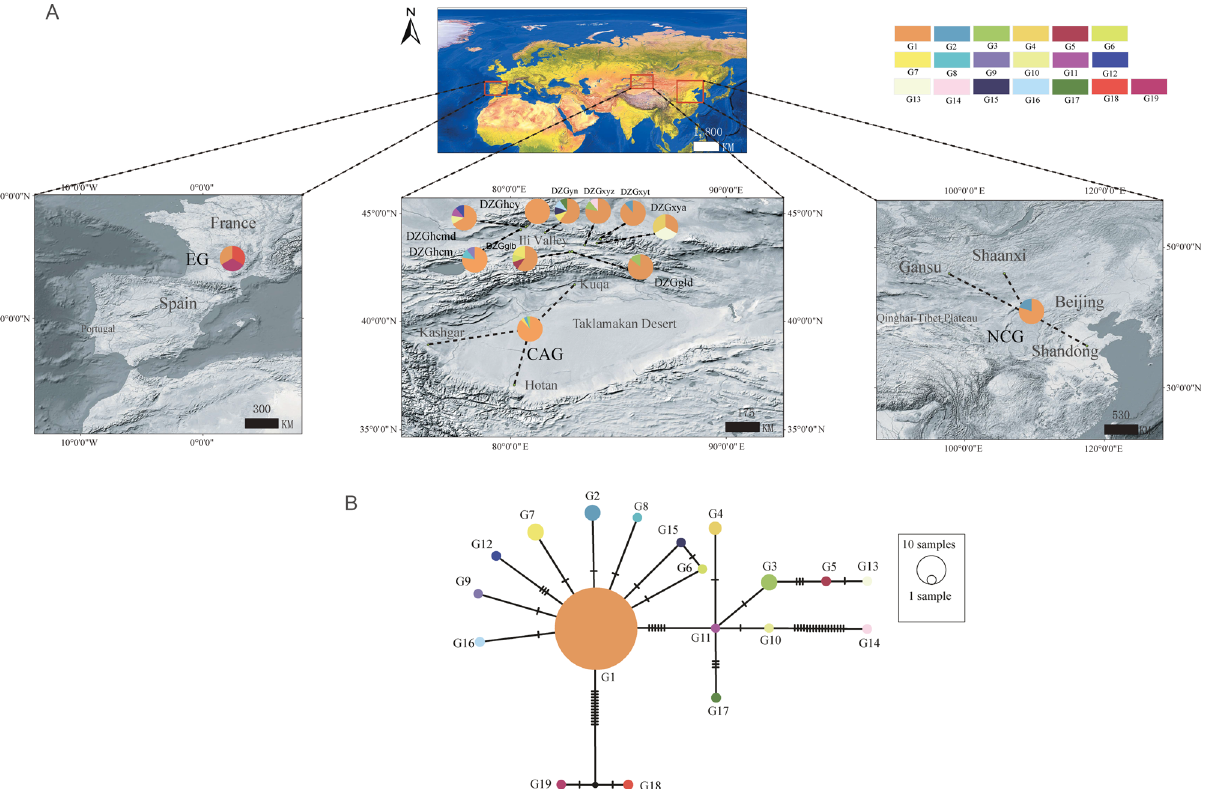
Figure 2. Geographic location and haplogroup distribution patterns of the 12 populations of P. armeniaca based on cpDNA dataset. ( A ) Geographic distribution of haplotyoes of P. armeniaca ; Pie chart size corresponds to the sample size of each population. ( B ) The haplotype network generated from the haplotyoes of P. armeniaca. The haplotype network generated from the 19 haplotypes of P. armeniaca . The small black circles shown an intermediate haplotype not detected in this study. All maps (Source: http:// ditu. ps123. net/ world/ 2363. html) were generated using ArcGIS ver. 10.V.10.2.2 (ESRI, CA, USA) and then improved in Adobe Illustrator CC (Adobe Systems Inc., CA,